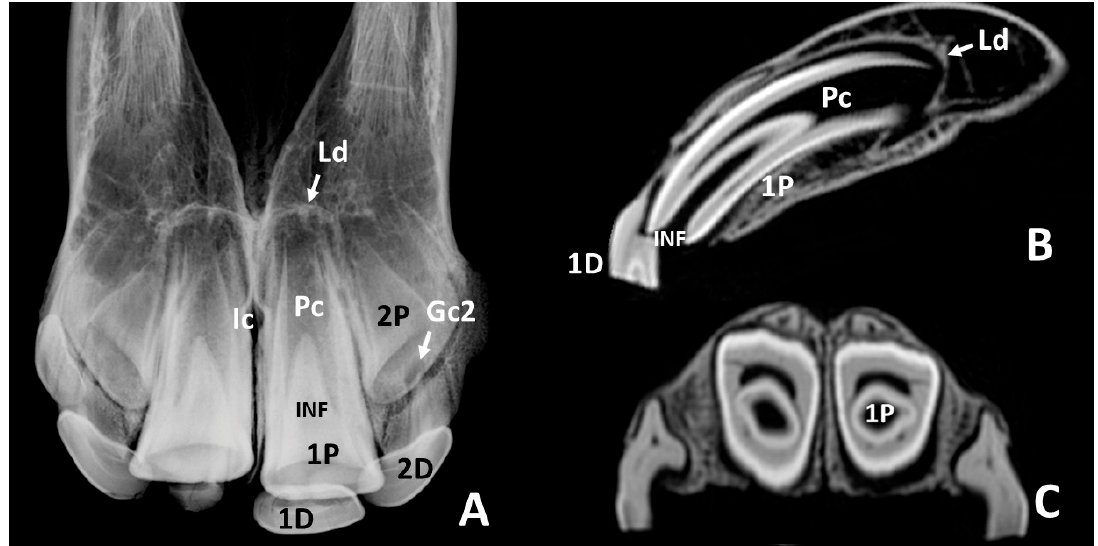
Figure 7. Intraoral radiographic images ( A ) and sagittal and transverse scans ( B , C ) of maxillary incisor arcade of one skull representative of group 2. 1D , remain of left 1st deciduous incisor—601; 2D , left 2nd deciduous incisor—602; 1P , left 1st permanent incisor—201; 2P , unerupted left 2nd permanent incisor—202; Pc , pulp cavity of the left 1st permanent incisor—201; Gc2 , gubernacular canal of 2nd permanent incisor—202; Ic , incisive canal; INF , infundibulum of the left 1st permanent incisor—201; Ld , lamina dura of the alveolus of the left 1st permanent incisor—201. A small remain of right 1st deciduous incisor—501—is also present on the labial side of the corresponding permanent tooth.